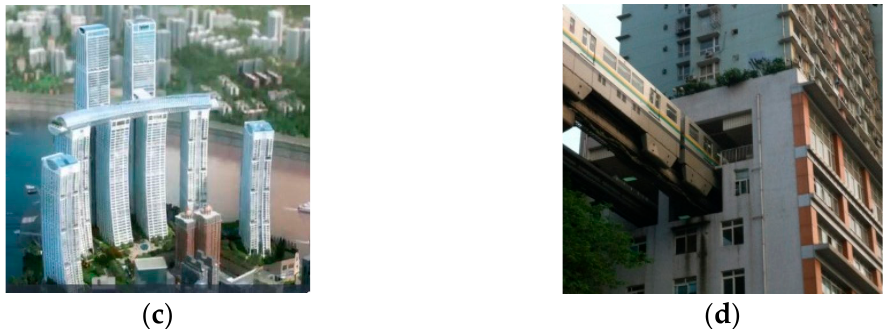
Figure 6. Spatial forms of buildings in urban areas: regular building ( a , b ); irregular building ( c , d ).